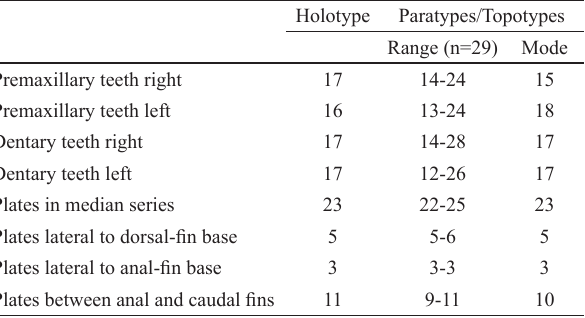
Table 2. Meristic data of Parotocinclus spilurus.